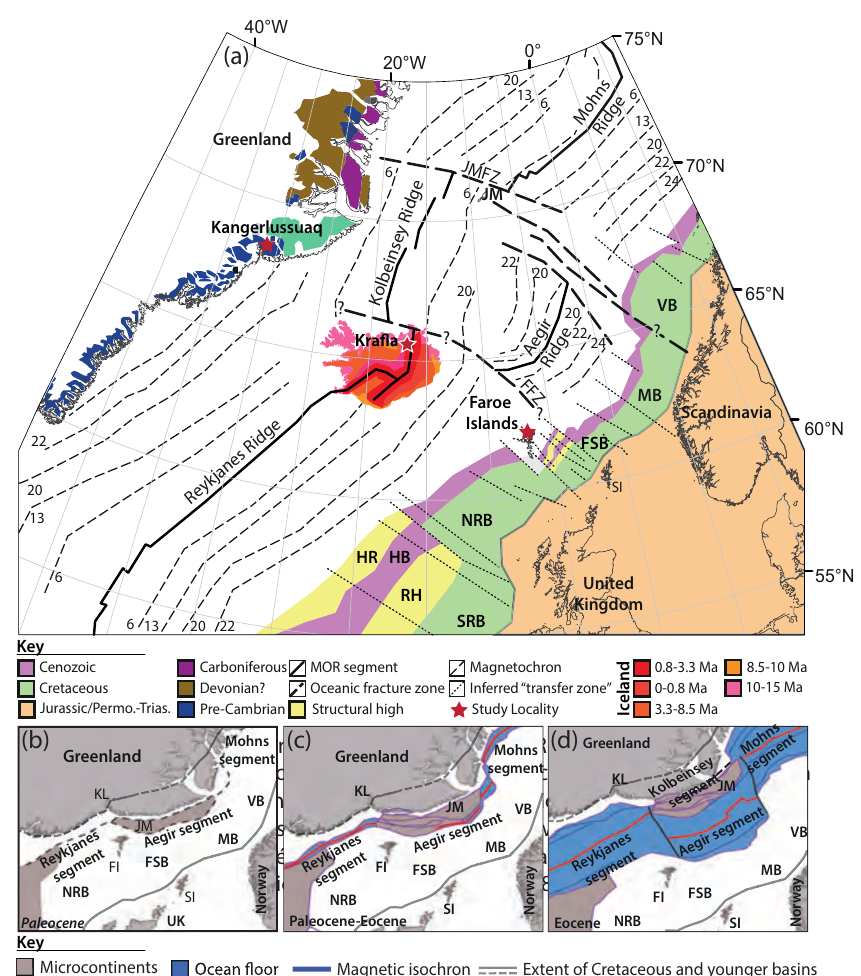
Figure 7. (a) NE Atlantic tectonic elements map: Hatton Rise (HR), Hatton Basin (HB), Rockall High (RH), South Rockall Basin (SRB), North Rockall Basin (NRB), Faroe–Shetland Basin (FSB), Shetland Islands (SI), Møre Basin (MB), Vøring Basin (VB), Jan Mayen (JM), Jan Mayen Fracture Zone (JMFZ), Tjörnes Fracture Zone (TFZ), and Faroes Fracture Zone (FFZ). The map was compiled using basin ages from Doré et al. (1997), oceanic magnetic anomalies from Gaina et al. (2009), and Iceland stratigraphic ages from Doré et al. (2008). Study localities are indicated by stars. (b–d) Schematic model for a segmented opening of the NE Atlantic during the Paleogene (after Ellis and Stoker, 2014). Faroe Islands (FI); Kangerlussuaq